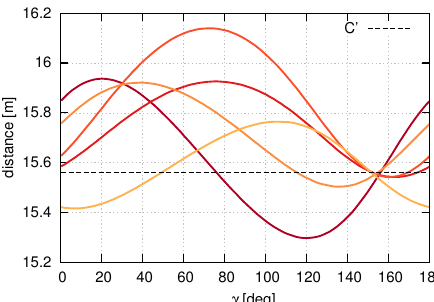
Figure 6: d ( ˜ C (cid:48) , γ, Q (cid:48) o ) as a function of γ for five random points ˜ C (cid:48) in the neighborhood of C (cid:48) . The ellipse Q (cid:48) o is the outer circle projection of a target placed a true distance of 15 . 56 m. Figure 7: Landscape of D ( ˜ C (cid:48) ) for an ellipse with major and minor axis 91 . 02 and 76 . 46 px, angle − 113 . 81 ◦ and center (379 . 43 , 120 . 55) . Marked points are the two candidates for the projected circle center C (cid:48) and the solution obtained employing the method in (Kim et al.,